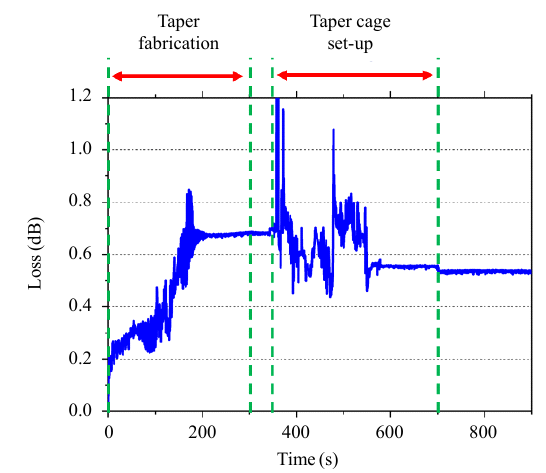
Fig. 2 Optical loss as a function of the time (taper waist diameter: 1 μ m; taper waist length: 10 mm). Taper fabrication happens between 0 s and 300 s and taper cage setting-up takes place between 350 s and 700 s.